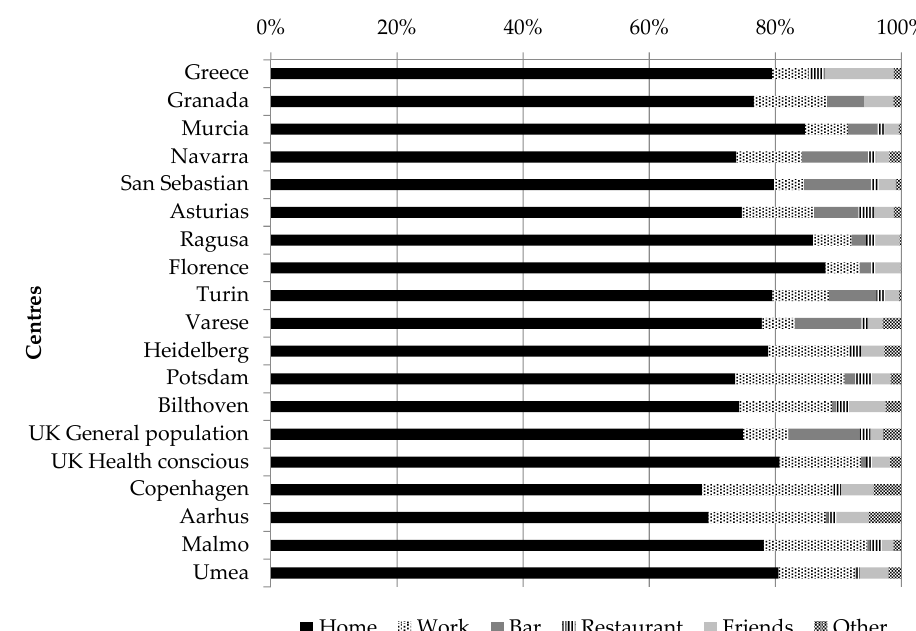
Figure 1. Proportion of coffee and tea consumption at different places of consumption, among men across EPIC centres; fully adjusted models among consumers only; “friends” refers to friends’